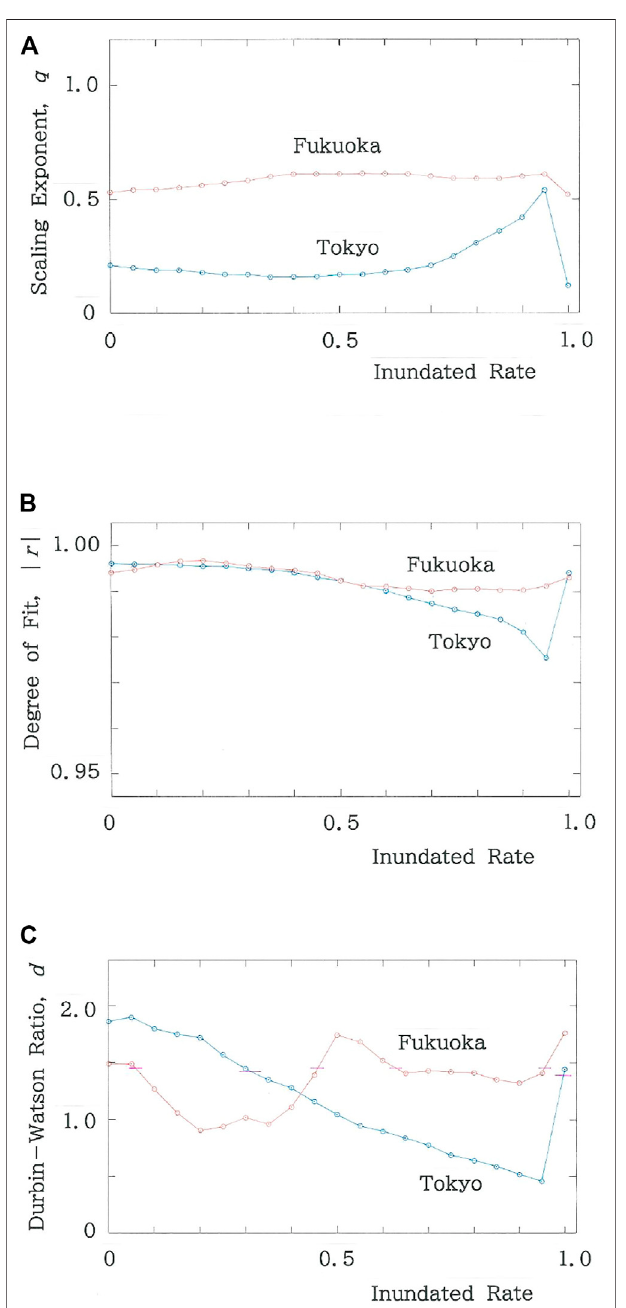
FIGURE8| Dependenceofoptimalparametersontheinundatedrateon the supposition that effects due to global warming will get more and more inevitable in the future. (A) Scaling exponent. (B) Degree of fi t. (C) Durbin- Watson ratio. The horizontal bar shows d (cid:1) d U .